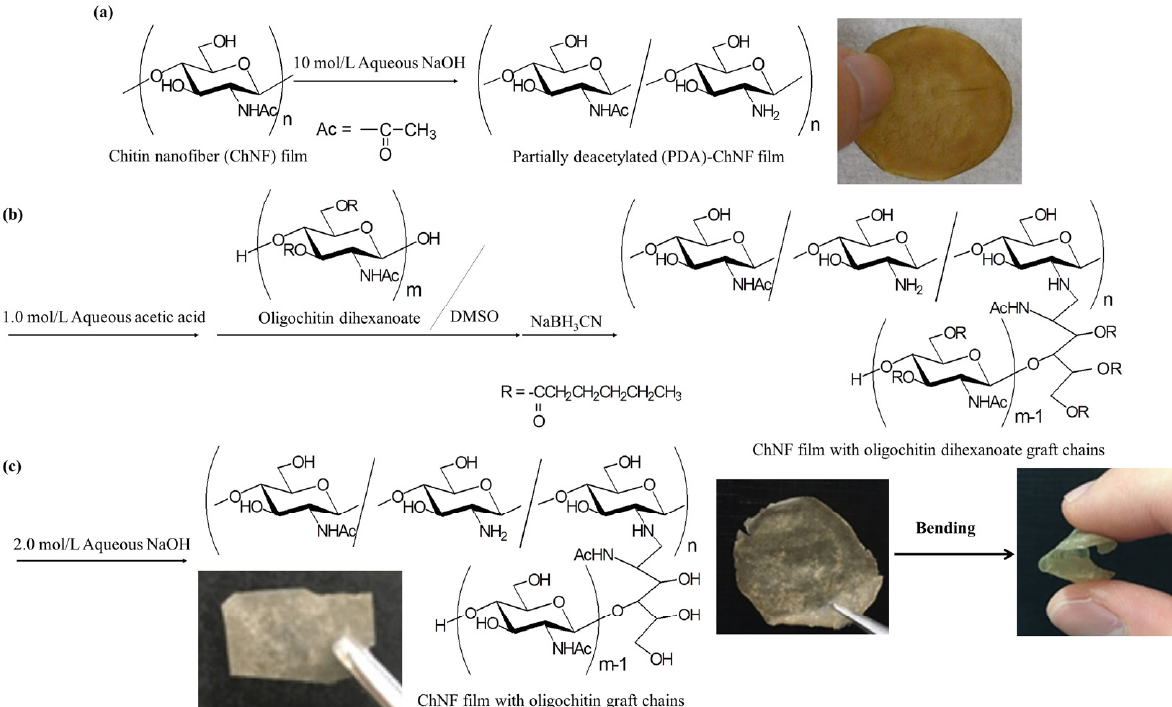
Figure 1. Procedures for ( a ) partial deacetylation of the chitin nanofiber (ChNF) film, ( b ) reductive amination of oligochitin dihexanoate with a partially deacetylated (PDA)-ChNF film, and ( c ) dehexanoylation of oligochitin dihexanoate graft chains on ChNF film.